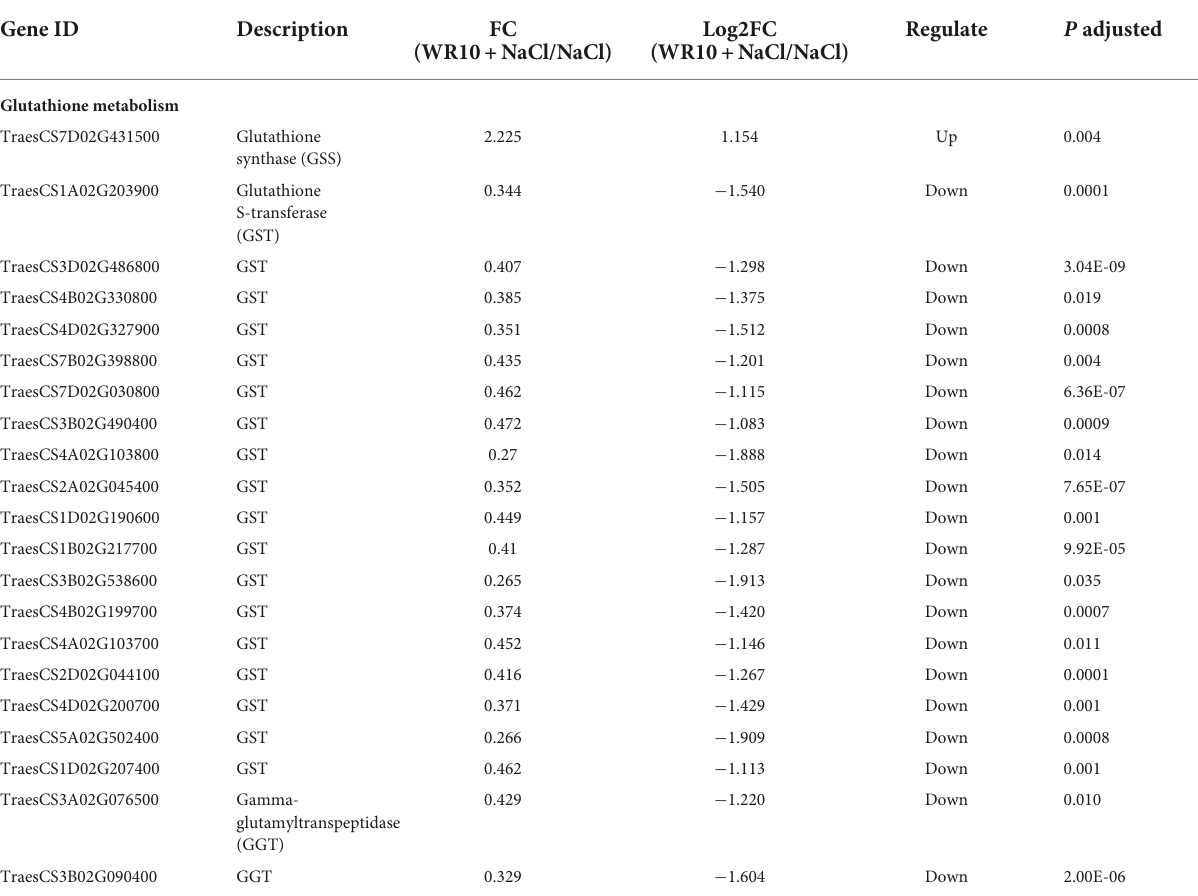
TABLE 1 Identified DEGs related to GSH metabolism in NaCl vs WR10 +